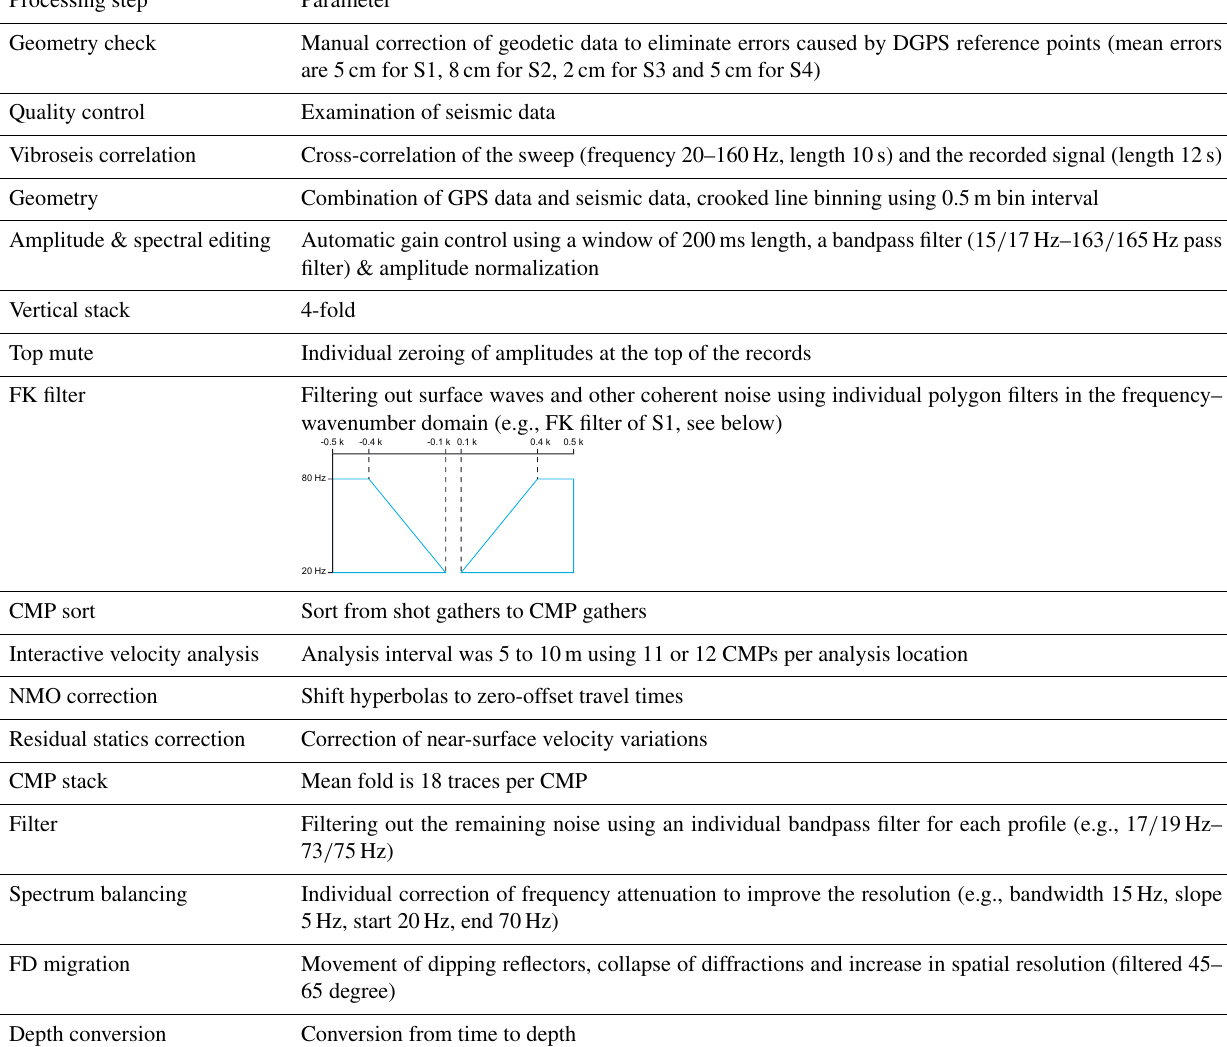
Table 2. Overview of the general processing sequence applied to the shear-wave seismic reflection data. Most of the processes were carried out iteratively. They are all individualized for differing data quality of the four profiles.